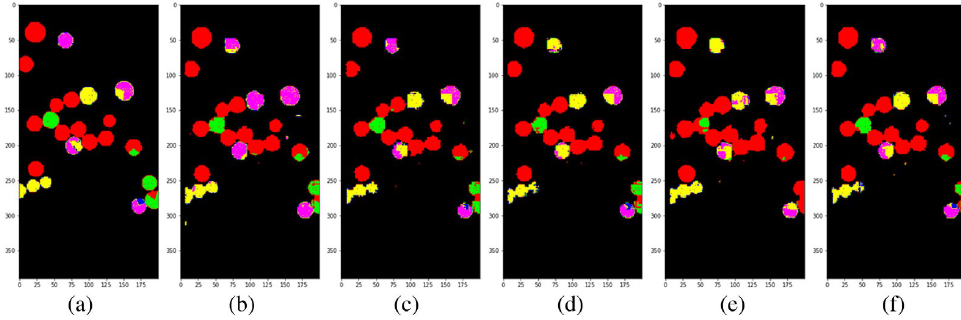
Figure 6. CD results for hyperspectral hermiston images ( a ) ground-truth, ( b ) U-Net, ( c ) RU-Net,